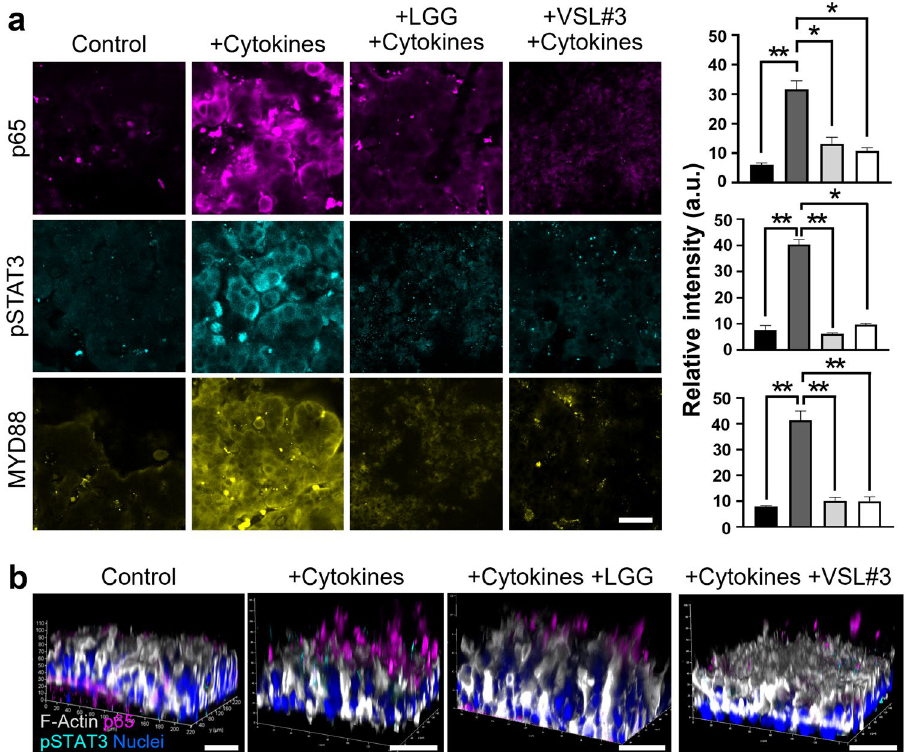
Figure 5. The anti-inflammatory effect of probiotic administration in a Leaky Gut Chip. ( a ) Probiotic co-cultures with either LGG (+ LGG, + Cytokines) or VSL#3 (+ VSL#3, + Cytokines) significantly reduced the expression of pro-inflammatory markers such as p65 (magenta), pSTAT3 (cyan), and MYD88 (yellow) compared to the cytokine-challenged group (+ Cytokines) on Day 3. A germ-free control that was not treated with a cytokine cocktail was used to provide a baseline expression of these three markers (Control). The column charts (right) show the quantification of the paired image. The black, dark grey, light grey, and white columns indicate Control, + Cytokines, + LGG + Cytokines, and + VSL#3 + Cytokines, respectively. Bar, 50 µm. * p < 0.05, ** p < 0.01. ( b ) The 3D reconstruction of z-stacked images that visualizes the spatial distribution of p65 and pSTAT3 on the inflamed leaky epithelium elicited by cytokine challenges in a Leaky Gut Chip. Nuclei and F-actin were counter-stained with DAPI and fluorescence-labeled phalloidin, respectively. Bars, 50